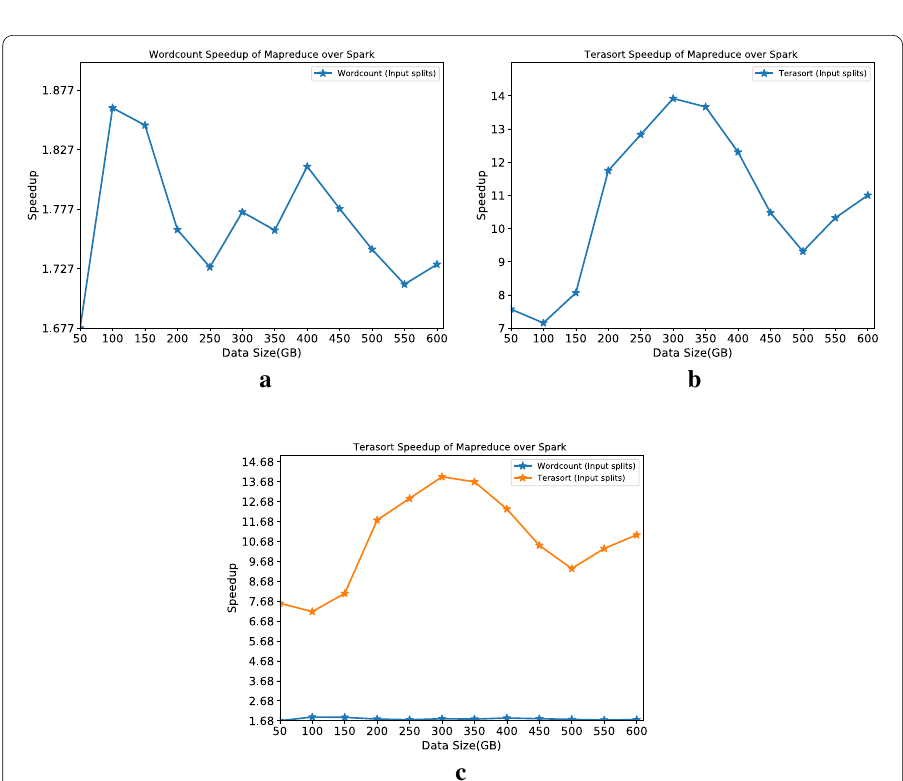
Fig. 8 Spark over MapReduce speedup on input splits and